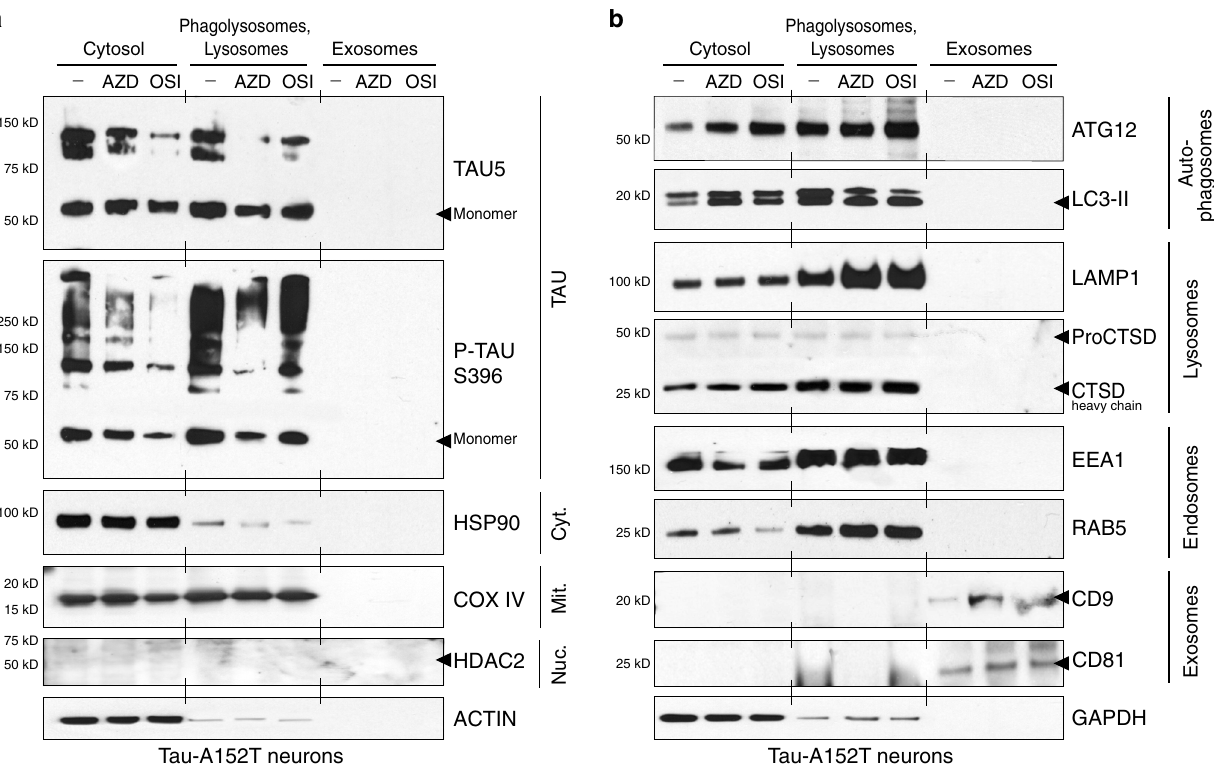
Fig. 5 mTORi promoted tau sequestration into phagolysosomes. Tau-A152T neurons (6-week differentiated FTD19-L5-RC6) were treated with vehicle ( – ), 10 μ M AZD2014 (AZD) or 10 μ M OSI-027 (OSI) for 8 h. Cell lysates were fractionated by density gradient and western blot analysis shows a total tau (TAU5) and P-tau S396 levels in cytosol, lysosomes/phagolysosomes and exosomes fractions; and b fraction-speci fi c markers. Key: Nuc, nuclear negative control; Cyt, cytosol; Mit, mitochondrial. Blots shown are representative of n = 2 biological with 10 μ M OSI-027 (Fig. 4j) or 10 μ M AZD2014 (Fig. 4k)